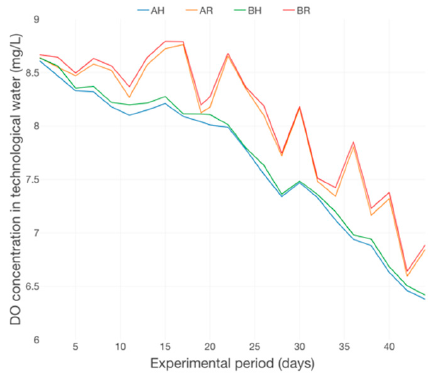
Figure 22. The dynamics of pH in technological water for each of the experimental variants. Water quality is a primary consideration for aquaponic crop production, especially in a recirculating aquaponic system. Deterioration of water quality parameters not only affects fish physiology, growth rate, and feed efficiency [63], but also affects plant crop performance, quality and/or yield, and N use efficiency. Yang and Kim [64], reported that regardless of management regimes, DO in aquaponics averaged at 7 mg/L, which was slightly above the tolerance limits of 6 mg/L [65] and with 30% higher than 5 mg/L, which is suggested for aquaculture in terms of DO level [66]. Given that the nitrifying bacteria have an optimal range of DO (4–8 mg/L) to promote nitrification process [67], the DO levels from our experiment (7.53–8.09 mg/L) were suffi- cient in aquaponic system. Also, was reported that the accurate pH ranges are 6–9 for fish growth, 5.5–6 for plants and 7–8 for nitrifying bacteria [68], so we can say that pH between 6.51 ± 0.19 and